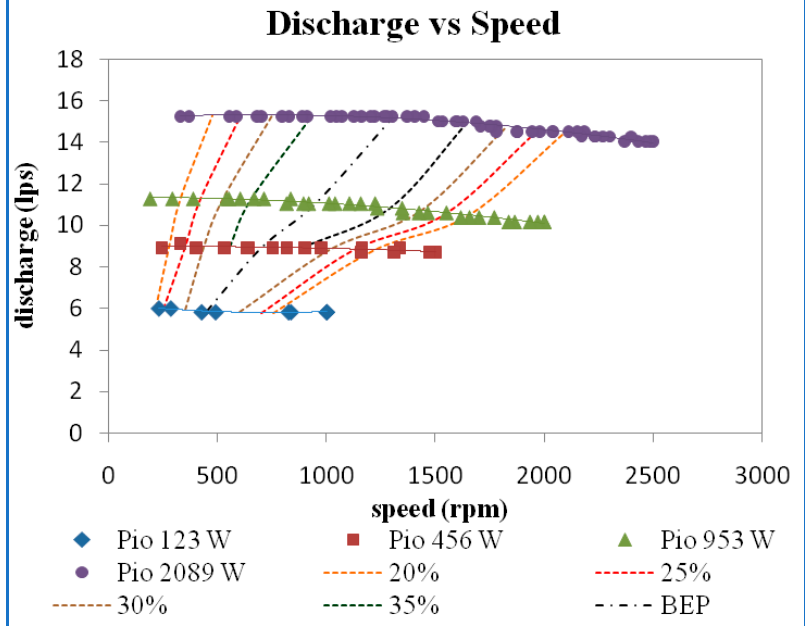
Figure 15. Discharge vs. speed and iso-efficiency line at 13 GVO. The plot of the variation between the head and speed for different power input at 16 mm GVO is shown in Figure 16. The head decreases with decreasing power input. A notable variation may be observed at higher speeds.